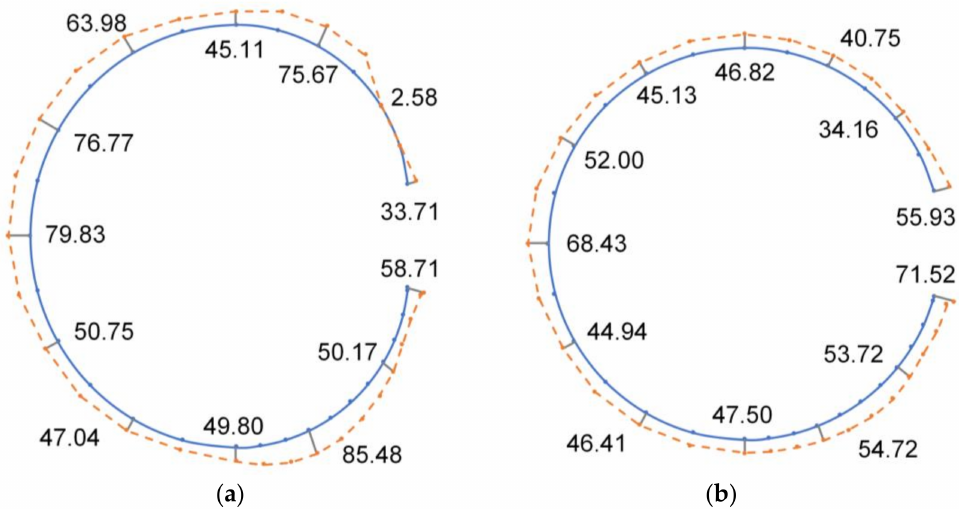
Figure 20. Mises stress of section 4 (MPa): ( a ) non-circle case; ( b ) circle